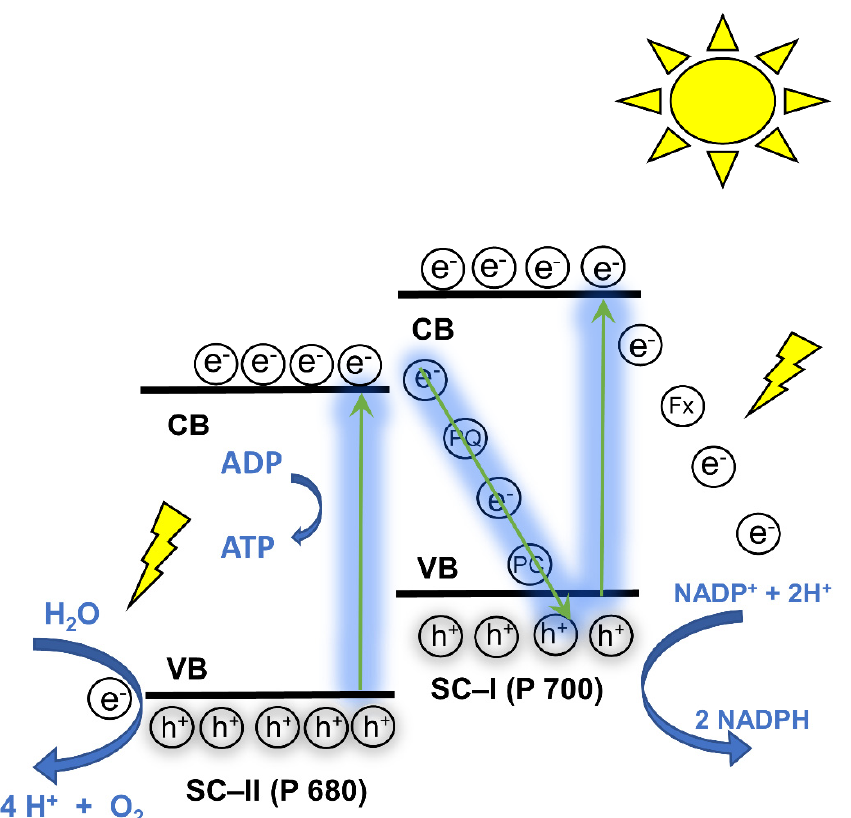
Figure 11. Natural photosynthesis mimicking the Z scheme [119]. Adapted with permission from Elsevier, Journal of Industrial and Engineering Chemistry , An overview of converting reductive photocatalyst into all solid-state and direct Z-scheme system for water splitting and CO 2 reduction, Raizada P. et al., License Number: 5391800879853, 2021.